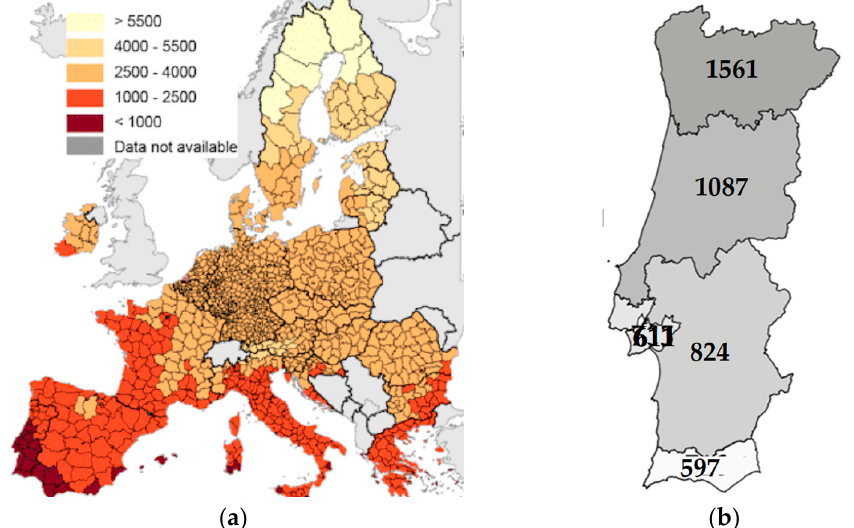
Figure 2. ( a ) Heating Degree Days in Europe (2021) and ( b ) in Portugal regions (2021) (adapted from [54]).